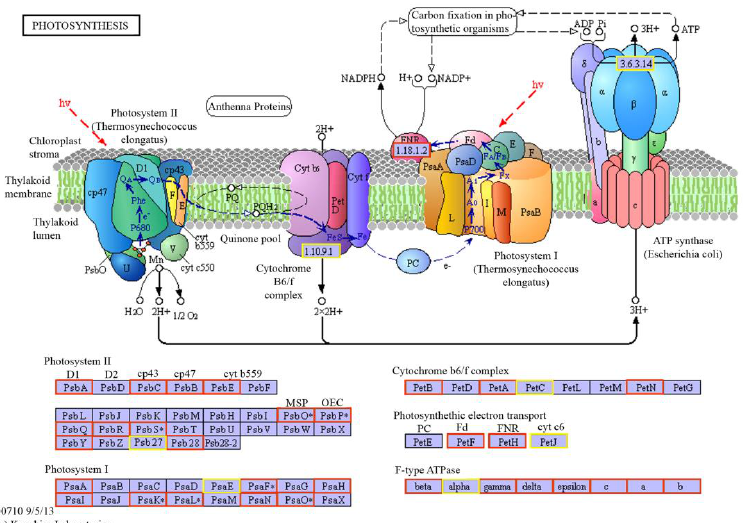
Figure 15. Photosystem and electron transport system pathway in P. kessleri FACHB-3316 generated by KEGG. (The red boxes indicate the ko nodes containing the up-regulated differential gene enzymes in 36 g/L CaCl 2 stress; the orange boxes indicate the ko nodes containing up- and down-regulated differential gene enzymes in 36 g/L CaCl 2 stress; the * indicate the ko nodes containing the up-regulated differential gene enzymes in 3.6 g/L CaCl 2 stress).